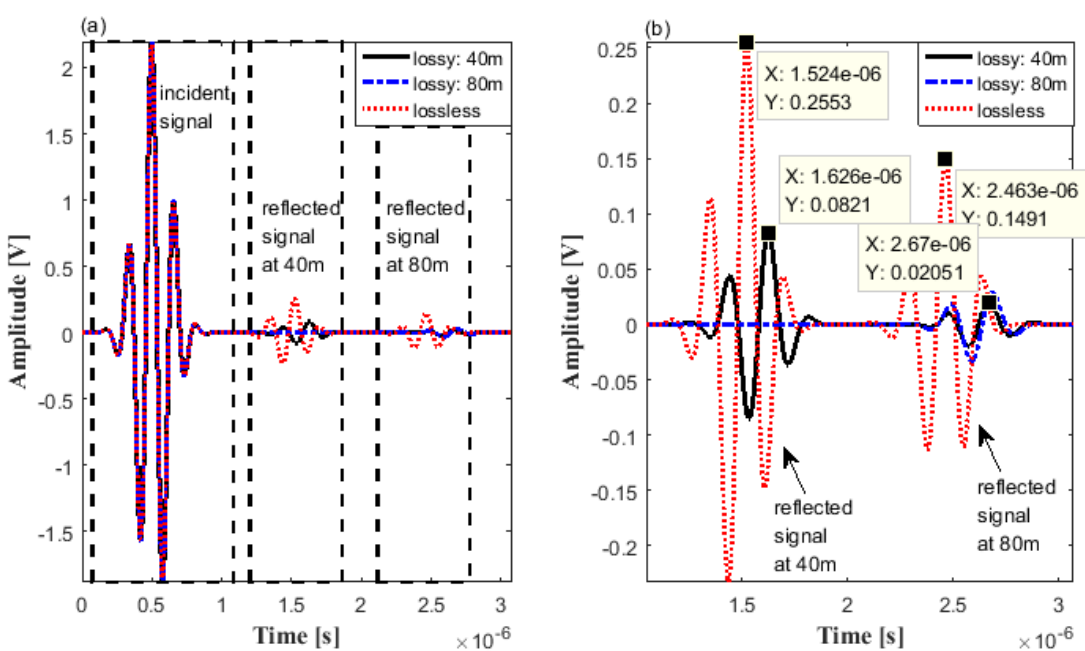
Figure 2. Experimental setup.